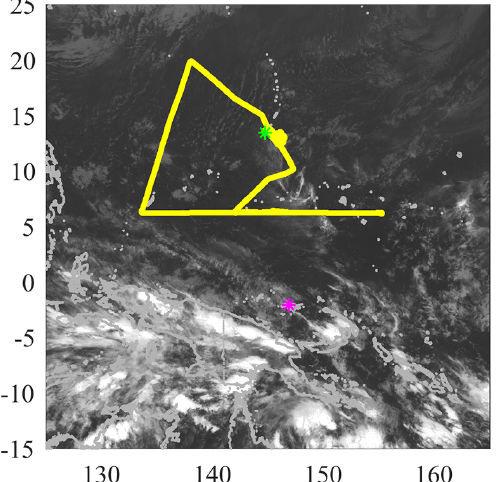
Figure 6. Satellite image of 6 March at 12:00UTC, coincident with flight RF04. Convection is minimal in the Northern Hemisphere and is concentrated mostly in the Southern